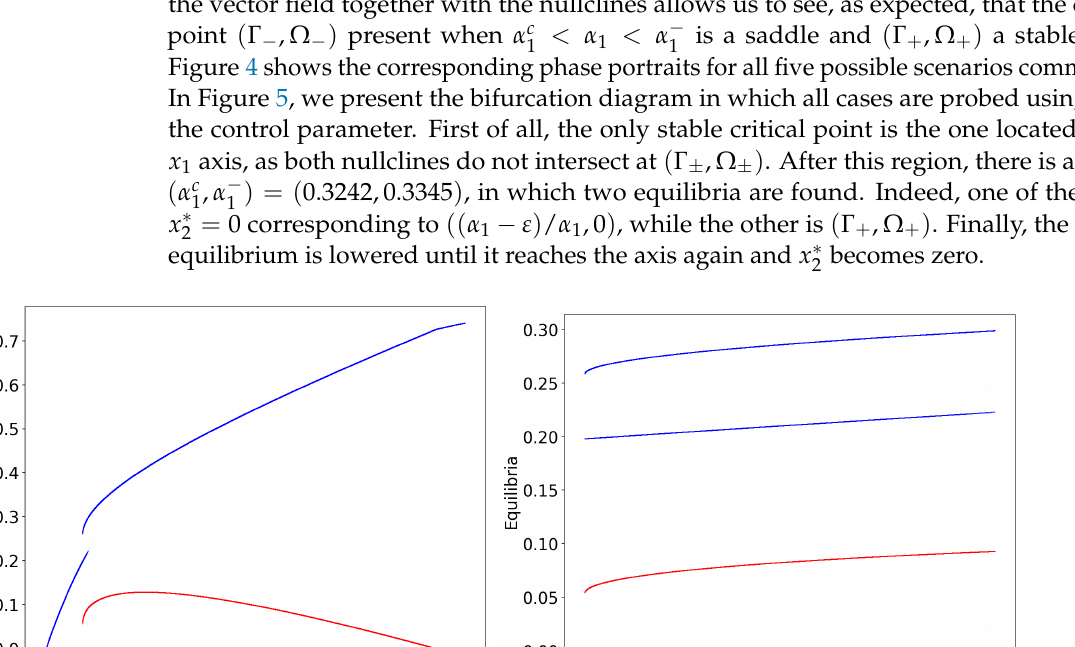
Figure 5. ( Left ) A bifurcation diagram when ε > ( k η k + α 2 ) 2 / ( 4 η k η ε k ) using α 1 parameters such that the four cases in Figure 4b–e are present. Specifically, α 2 = 0.14, ε = 0.26, k = 1, η k = 2.75, η ε = 2.25. Stable equilibria are represented in blue for x ∗ showing the coexistence of two stable equilibria; one of which implies the extinction of x 2